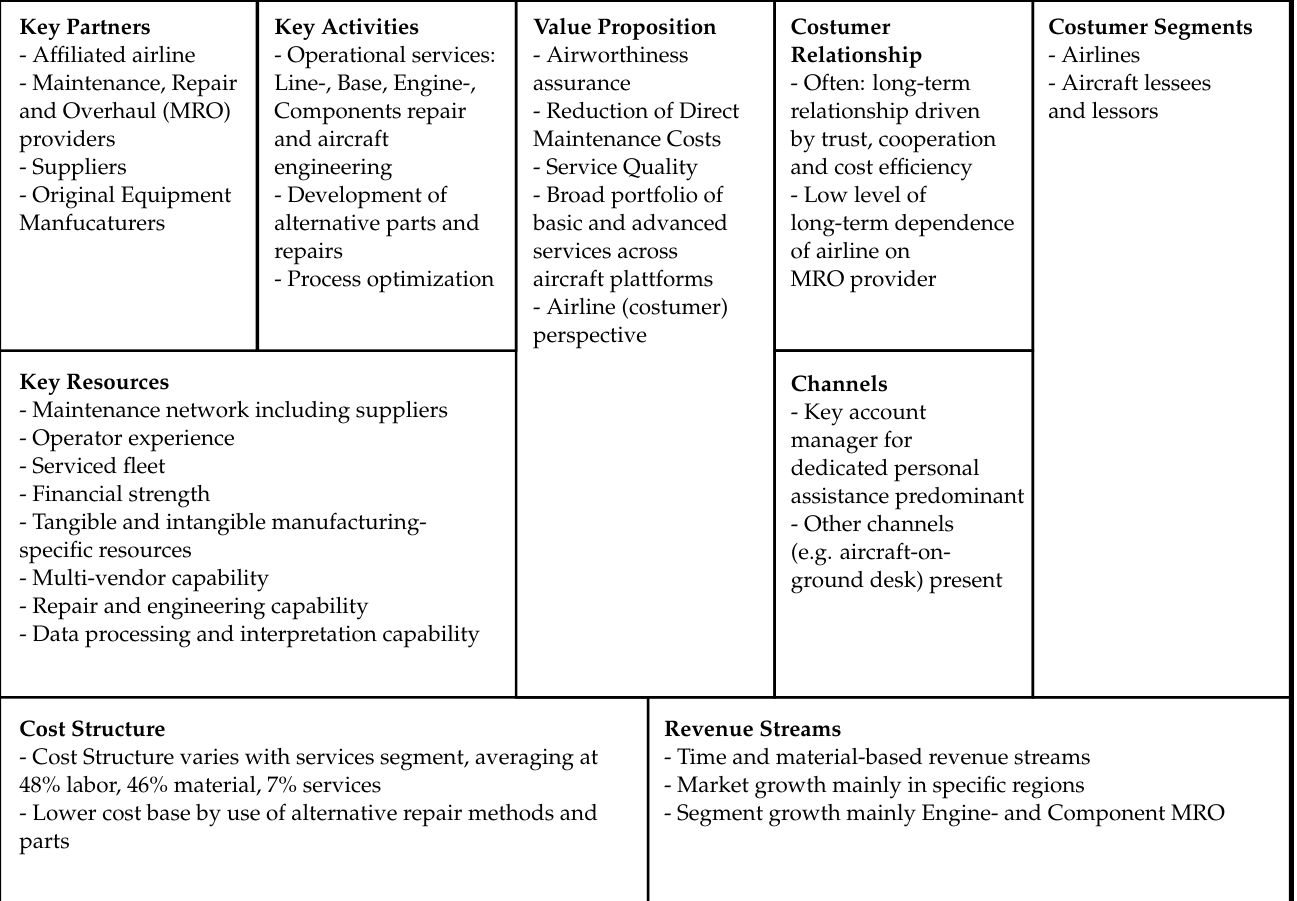
Figure 4. Generic business model canvas for an MRO provider. Reproduced with permission from Wirths